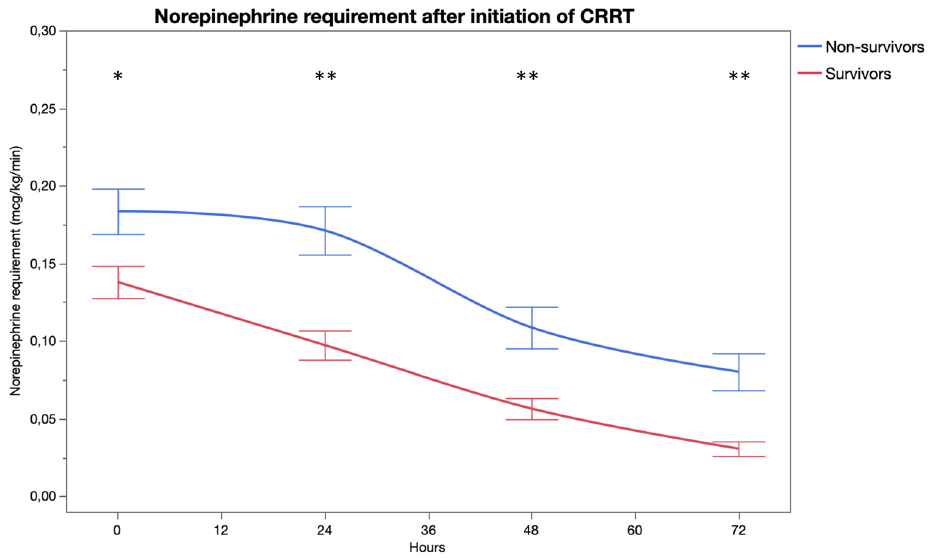
Figure 2. Norepinephrine requirement by time (*p < 0.01, **p < 0.001). The figure was generated using JMP Pro 15.1.0 software. Copyright 2019 © SAS Institute Inc. JMP Pro and all other SAS Institute Inc. product or service names are registered trademarks or trademarks of SAS Institute Inc., Cary, NC,